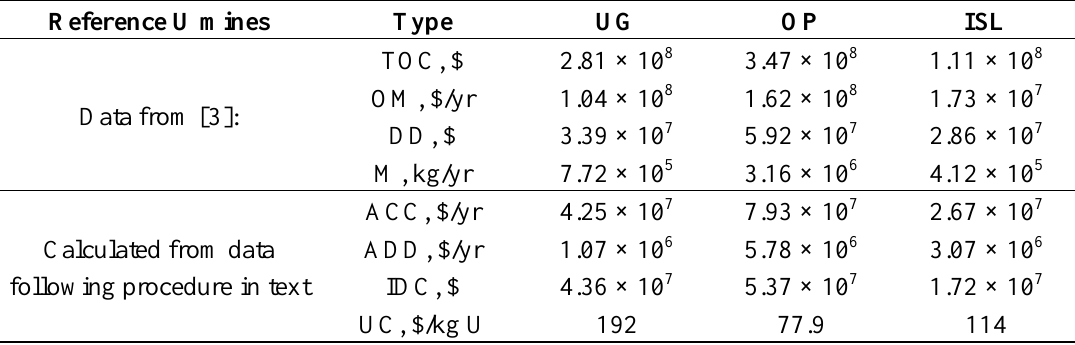
Table 1. Reference data for costs calculation from the WISE Uranium Project